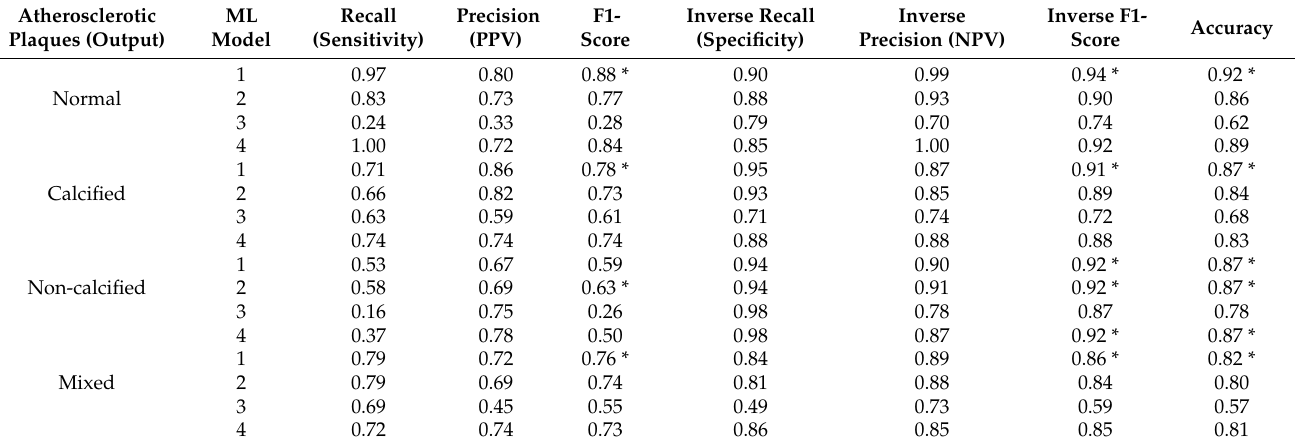
Table 3. The diagnostic performance of each ML model in classifying the atherosclerotic plaques. Atherosclerotic ML Plaques (Output)